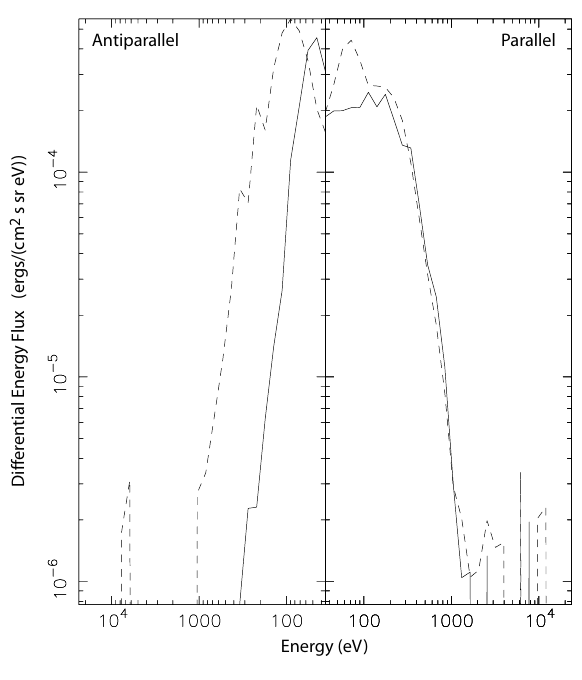
Fig. 12. Two slices of rebinned pitch angle distributions observed by Cluster 1. The left-hand side of the figure represents electrons moving antiparallel to the magnetic field, and the right-hand side represents parallel-moving electrons. The solid line represents the distribution at 01:23:20 UT, shortly before the antiparallel electron signature was observed. The electron distribution exhibited a paral- lel anisotropy, as is also evident in Fig. 11 (first vertical dotted line). At 01:23:28 UT (inside the antiparallel electron signature, denoted by the second vertical dotted line in Fig. 11), there is no signifi- cant change in the distribution of electrons moving parallel to the magnetic field, but there is a clear energisation of the antiparallel- moving electron population.